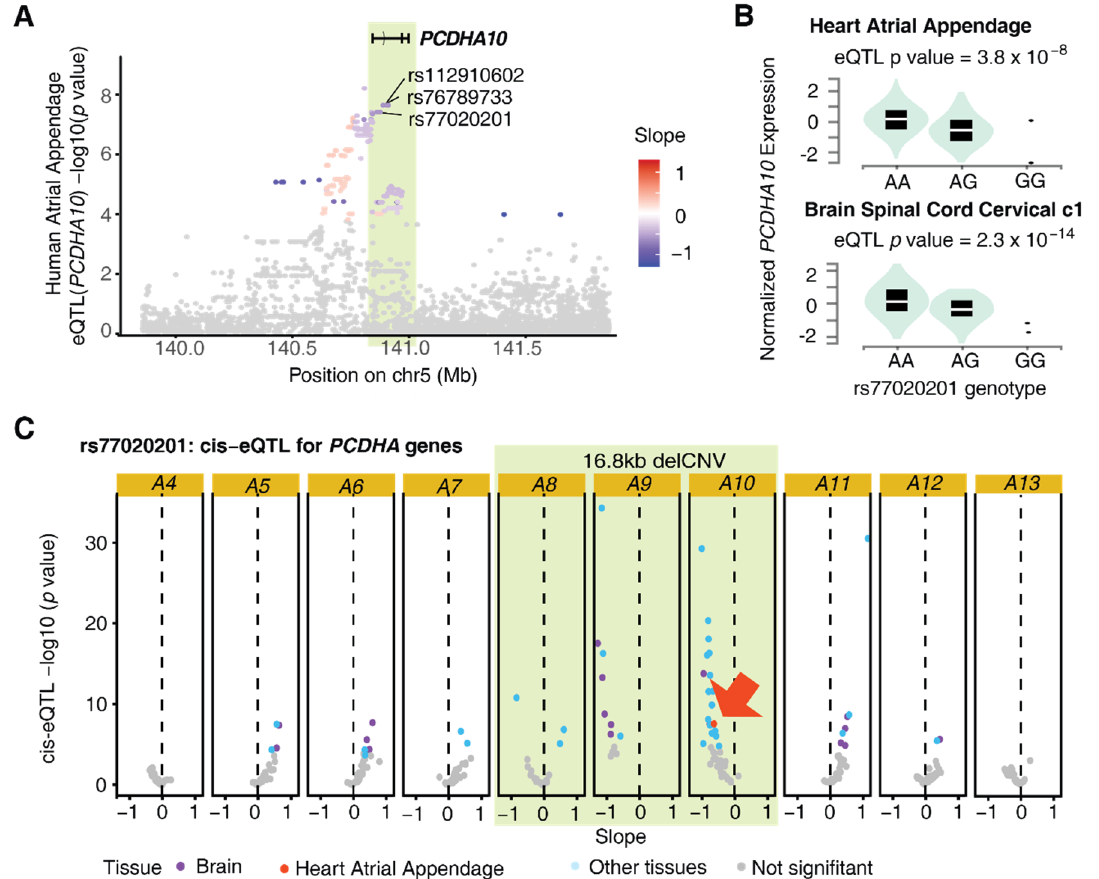
Figure 3 . cis-eQTL analysis of PCDHA delCNV impact on PCDHA gene expression. ( A ) GTEx database showed in the atria, three tagSNPs among top 5 cis-eQTLs were associated with significant change in PCDHA10 expression. ( B ) eQTL obtained using GTEx data showed reduced expression of PCDHA10 associated with the 16.8 kb PCDHA delCNV tracked by rs7702020 (A/G, non-risk/risk allele). p -values adjusted to the β distribution. ( C ) Volcano plot shows cis-eQTL tracked expression of the PCDHA cluster in different human tissue via rs77020201 for the 16.8kb PCDHA delCNV. Negative/positive slope indicates decrease/increase expression respectively. Grey dots denote nonsignificant cis-eQTL associations.